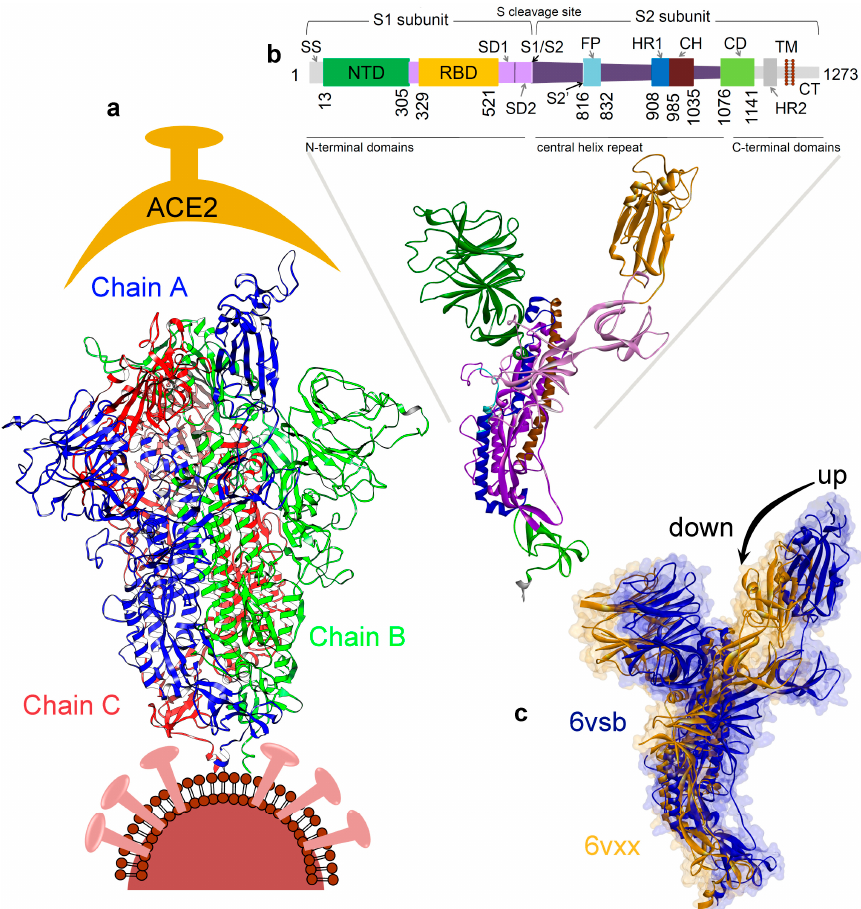
Figure 1. Severe acute respiratory syndrome coronavirus 2 (SARS-CoV-2) spike protein structure and function. ( a ) The homotrimer spike glycoprotein (PDB ID. 6vsb) [18]. ( b ) Di ff erent domains of the spike protein that includes; signal sequence (SS), the N-terminal domain (NTD), receptor-binding domain (RBD), subdomain 1 and 2 (SD1&2), protease cleavage sites (S1 / S2 / S2 (cid:48) ), fusion peptide (FP), heptad repeat 1 and 2 (HR1&2), central helix (CH), connector domain (CD), transmembrane domain (TM), and cytoplasmic tail (CT) [18,19]. ( c ) Receptor binding domain (RBD) illustrating the “up” or “open” (PDB ID. 6vsb [18]) and “down” or “closed” (PDB ID. 6vxx [31])